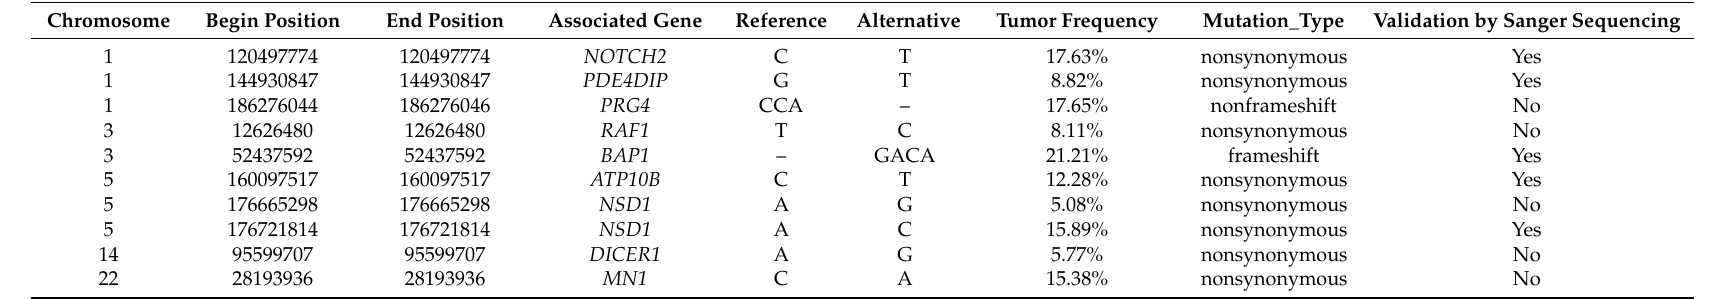
Table 2. List of somatic mutations (percentage of mutant reads